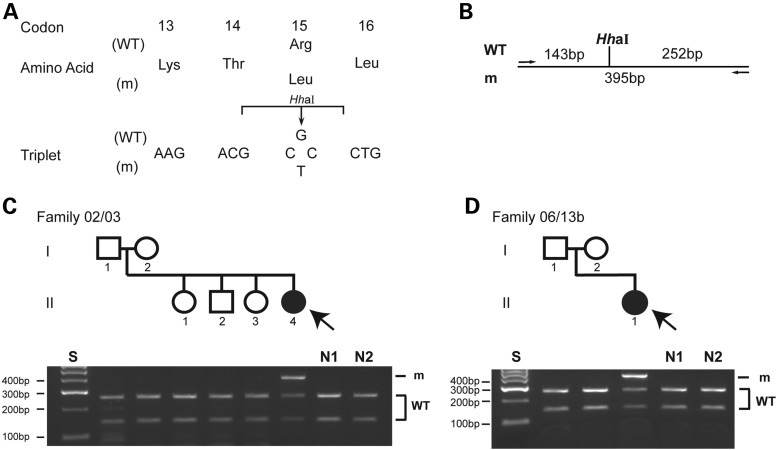
Detection of de novo AP2S1 mutations in families 02/03 and 06/13b. (A) DNA sequence analyses of the probands (arrowed) revealed a G-to-T transversion at codon 15, predicted to result in a missense amino acid substitution of Arg to Leu, and loss of a HhaI restriction endonuclease site. (B) Restriction map showing that HhaI digestion would result in two products of 143 and 252 bp from the wild-type (WT) sequence, but would not affect the mutant (m) sequence. PCR and HhaI digestion revealed the probands [individual II.4 of family 02/03 (C) and individual II.1 of family 06/13b (D)] to be heterozygous for the Arg15Leu mutation. The absence of the Arg15Leu mutation in the unaffected parents of both probands is consistent with the mutation arising de novo.